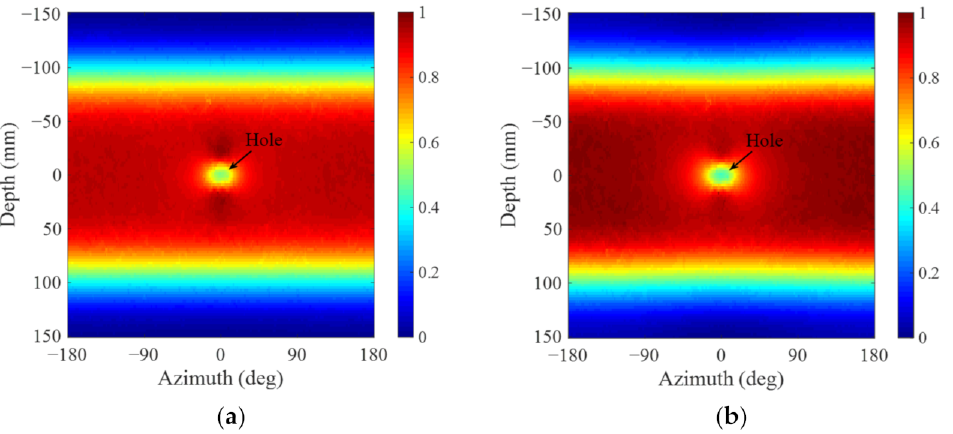
Figure 2. Depth-azimuth images of normalized magnetic flux density (MFD) at sampling times: ( a ) 10 ms; ( b ) 20